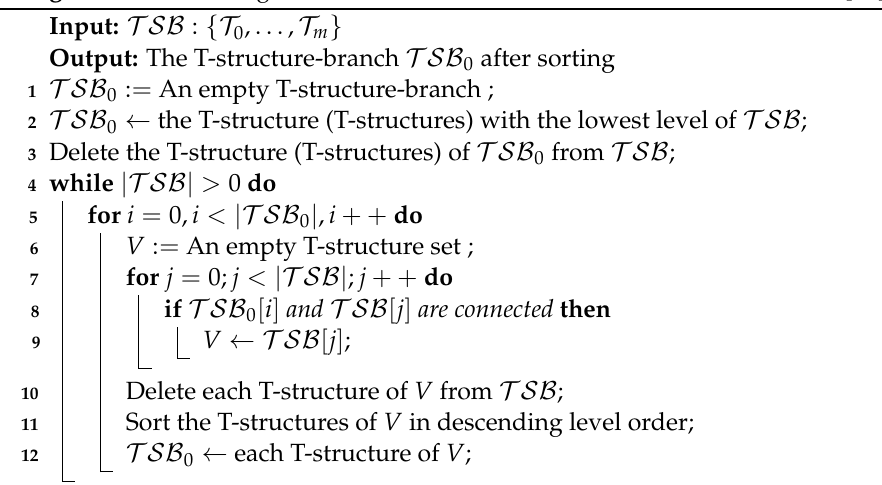
Algorithm 1: Ordering the T-structures for each T-structure-Branch of T k + 1